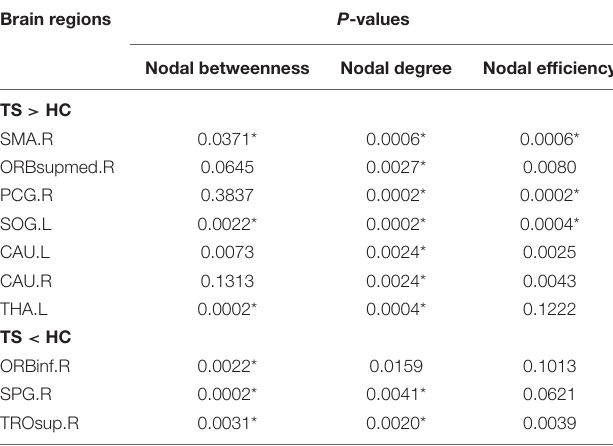
TABLE 2 | Regions showing altered node centrality (including nodal betweenness, nodal degree, and nodal efficiency) in patients with TC and HCs. Brain regions P -values Nodal